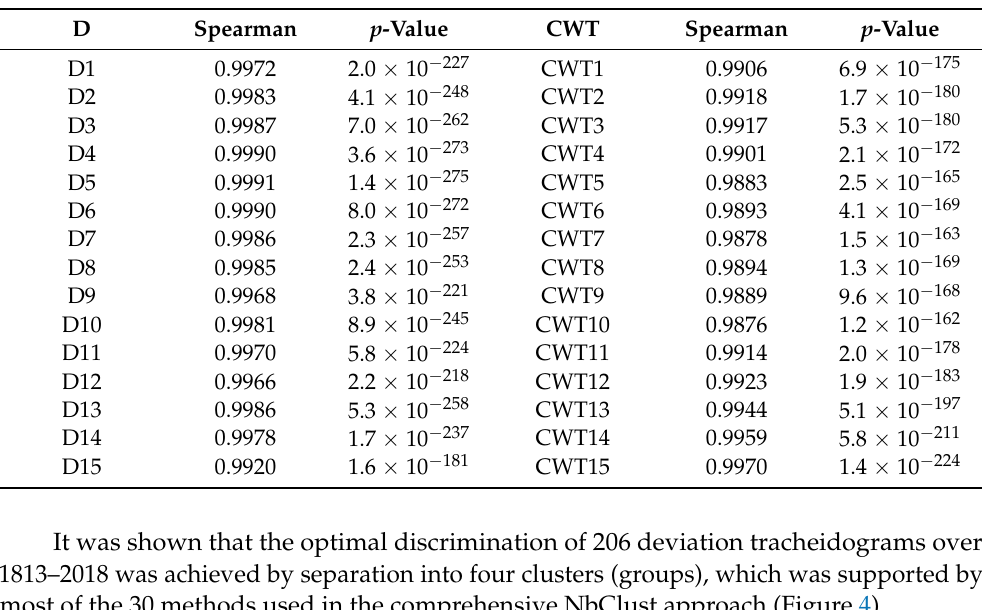
Table 1. Spearman rank correlation coefficients (S) and p -values obtained between the deviation tracheidograms obtained by the methods A and B for 15 radial cell size D (D1, D2, D3, . . . , D15) and 15 cell wall thickness CWT (CWT1, CWT2, CWT3, . . . , CWT15) over 1813–2018.